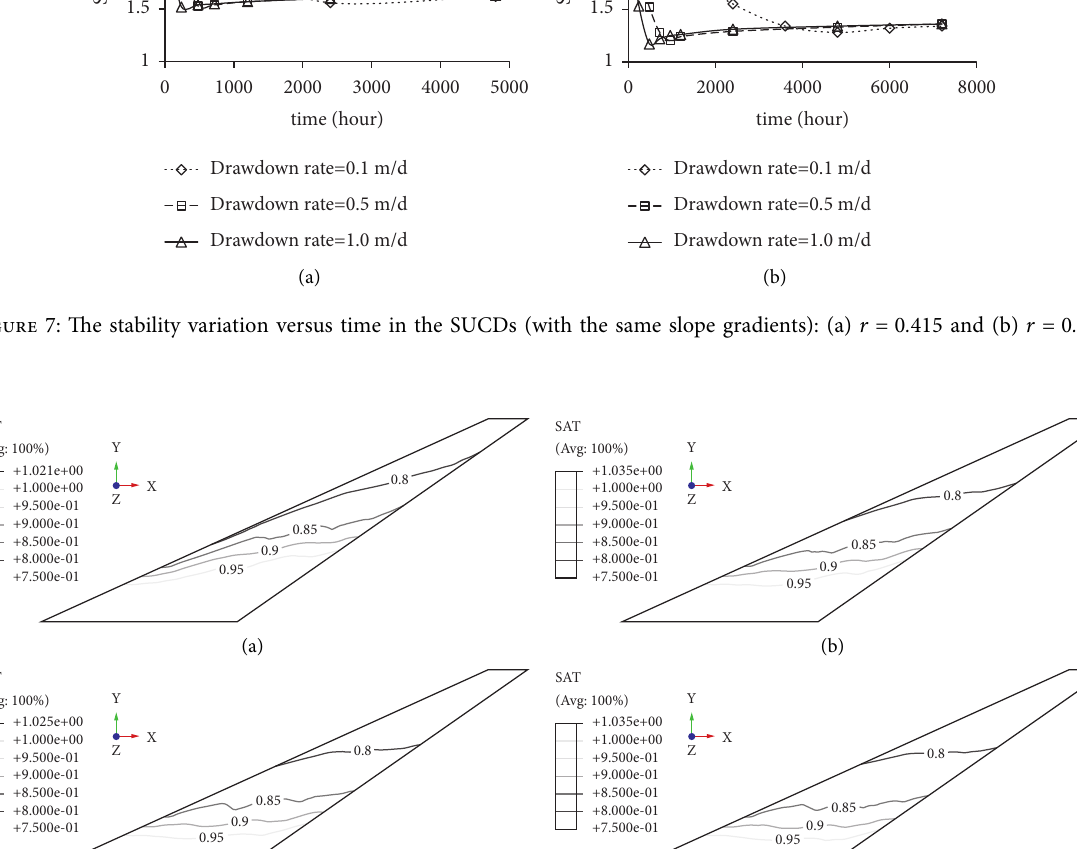
Figure 8: The saturation distribution variation versus time in the impervious core of the SUCD: (a) 1,200h, (b) 2,400h, (c) 4,800h, and (d) 7,200h.